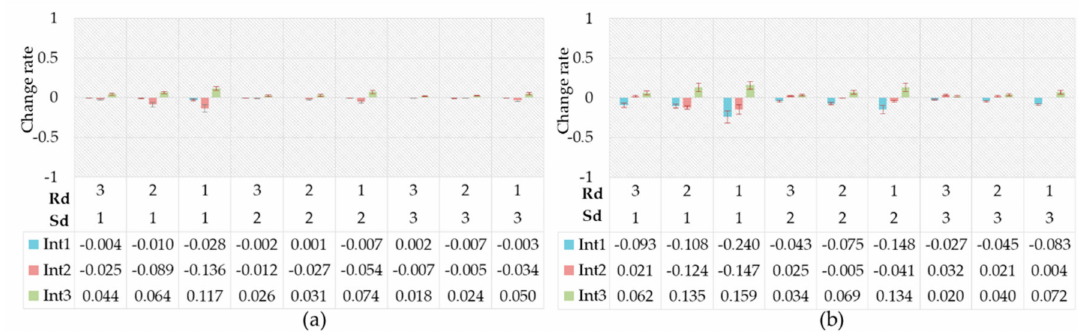
Figure 18. Change rates of driving intention probability. ( a ) Caused by relief; ( b ) Caused by